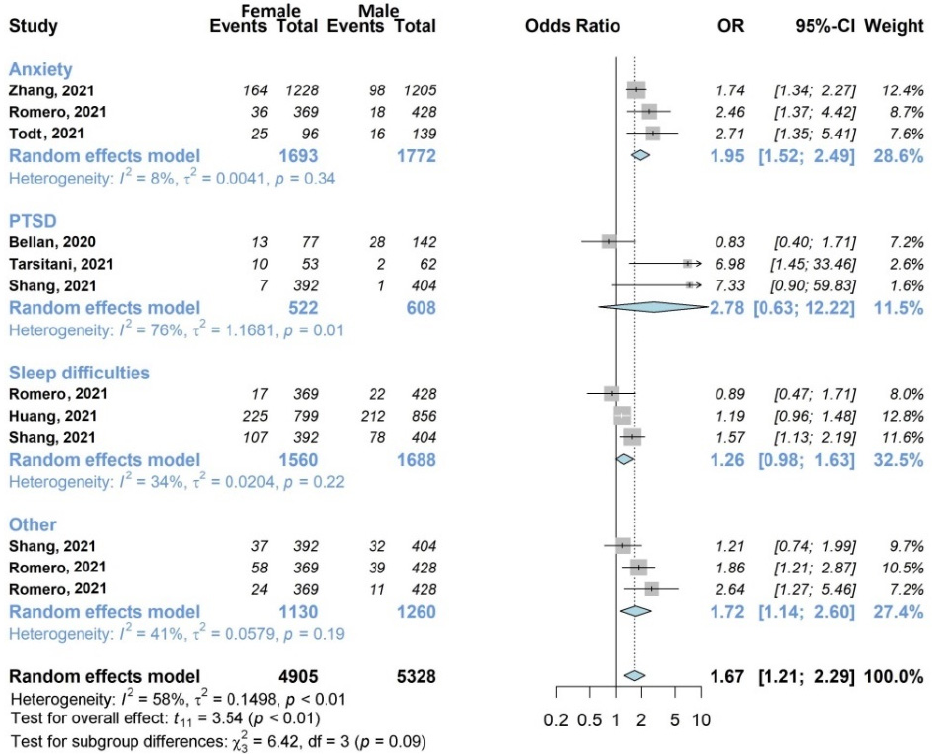
Figure 5. Forest plots of adjusted analyses for association between sex (female) and mental health. HKSJ, Hartung-Knapp-Sidik-Jonkman.